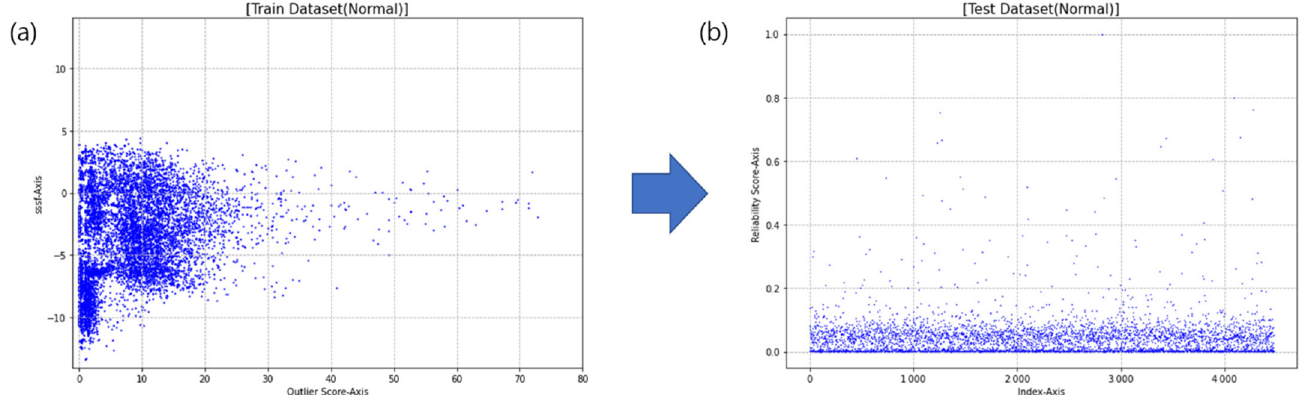
Figure 10. Process of calculating the reliability score of the test dataset with the training dataset of malware dataset: ( a ) SSSF/outlier score distribution calculated from the training dataset labeled normal; ( b ) reliability score distribution of the data predicted as normal in the test dataset.